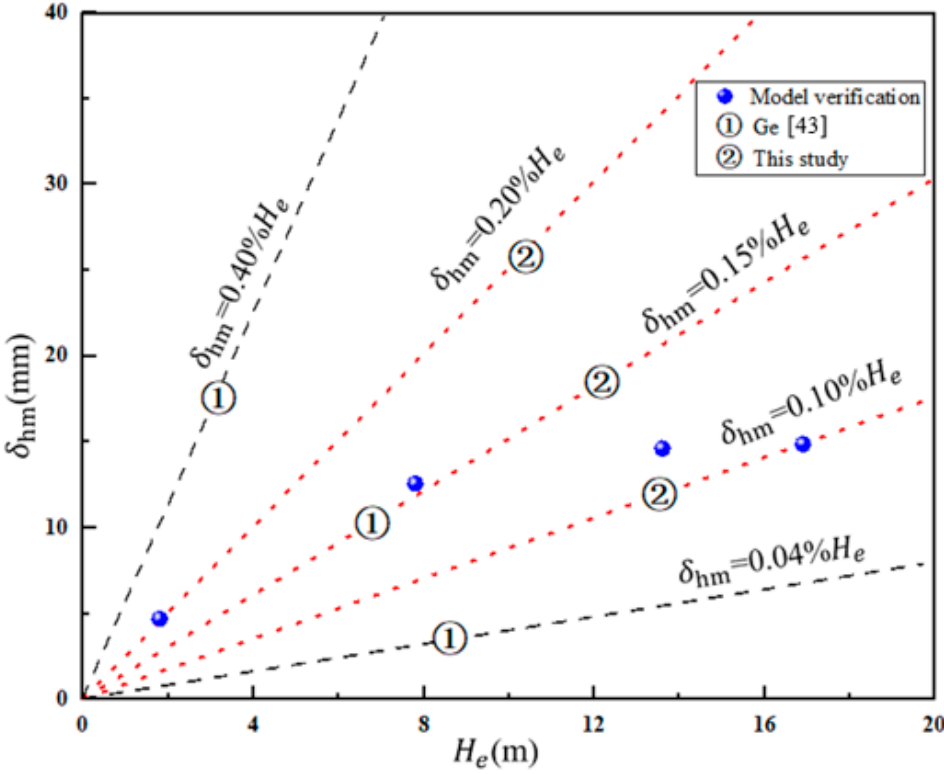
Figure 2. Relationship between maximum wall deflections and final excavation depths.